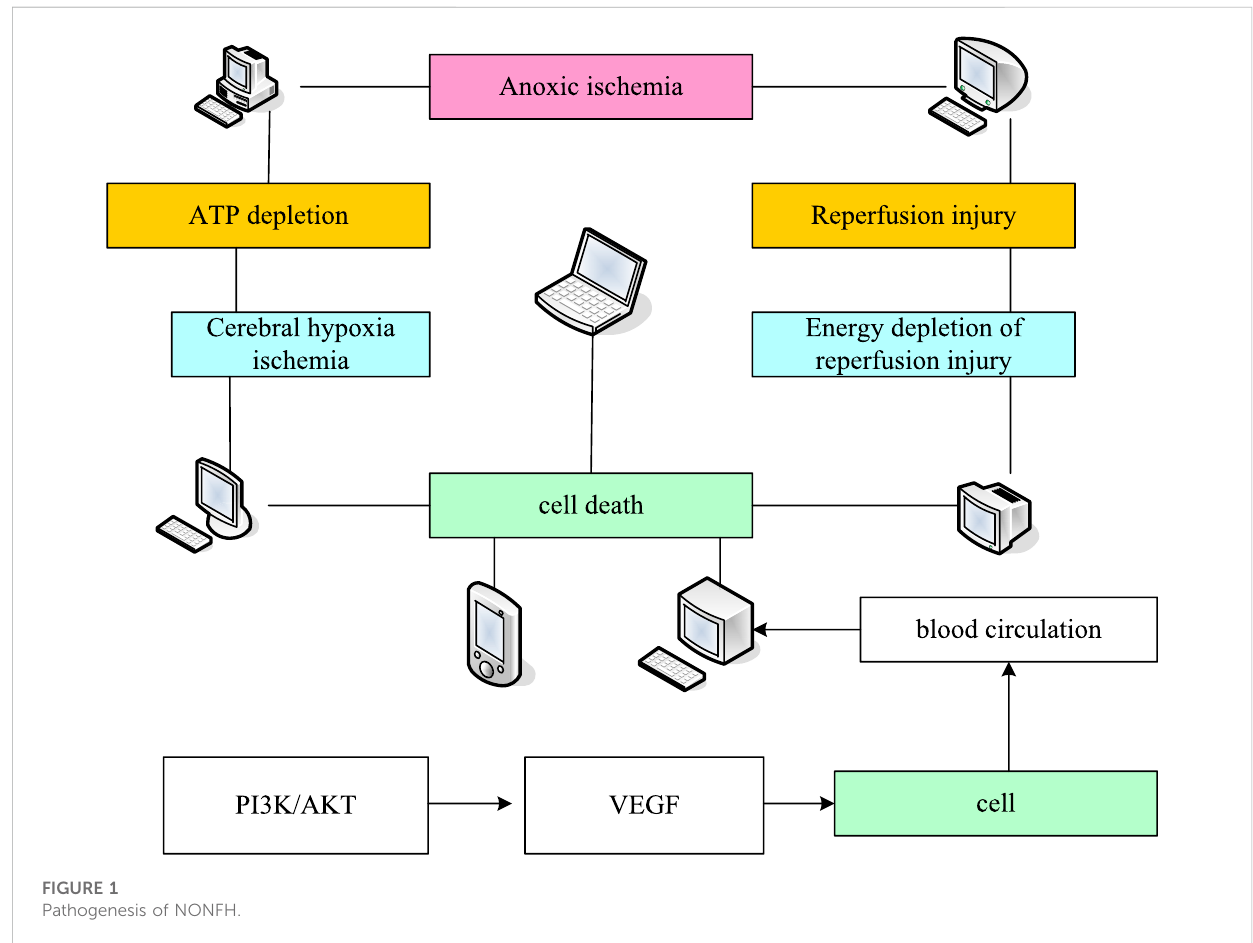
FIGURE 1 Pathogenesis of